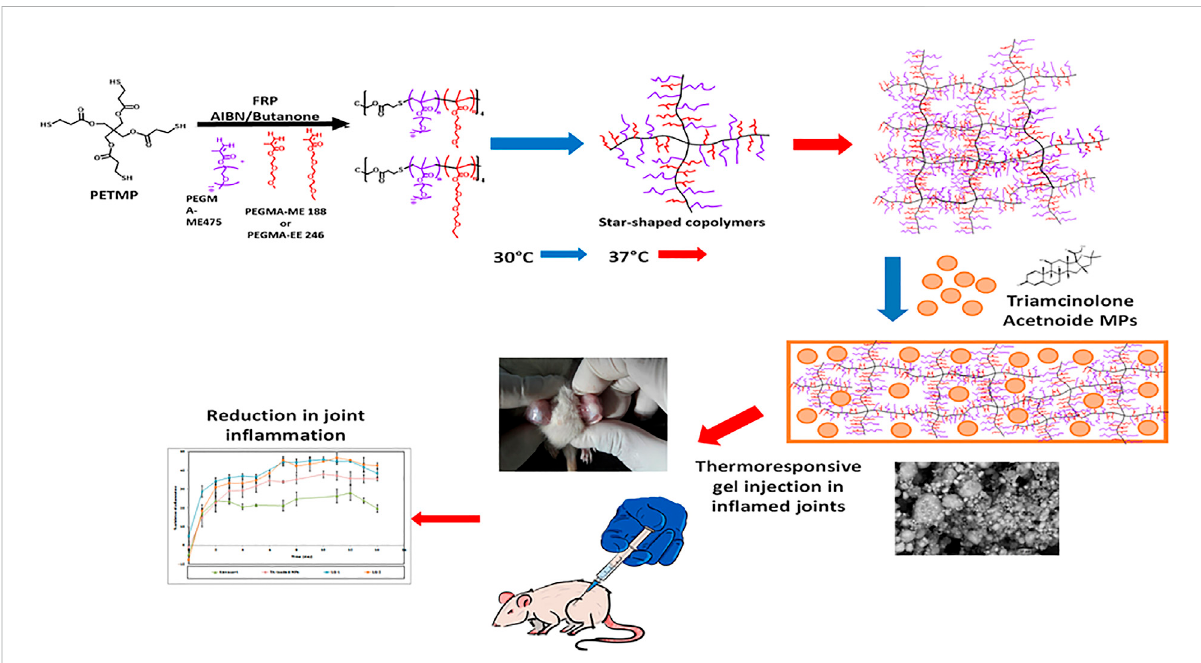
FIGURE 3 Schematic presentation of preparation of Triamcinolone acetonide (TA)-loaded MPs-in-hydrogel systems which are thermo-responsive.